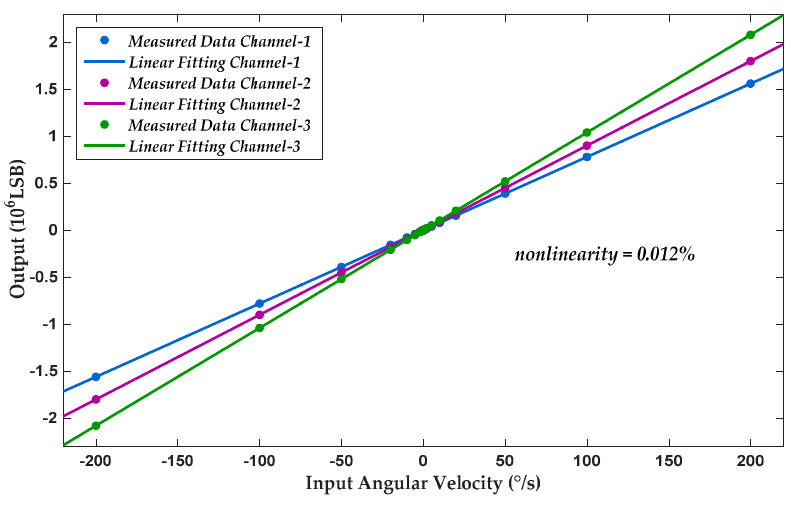
Figure 19. Measured DC transfer function.